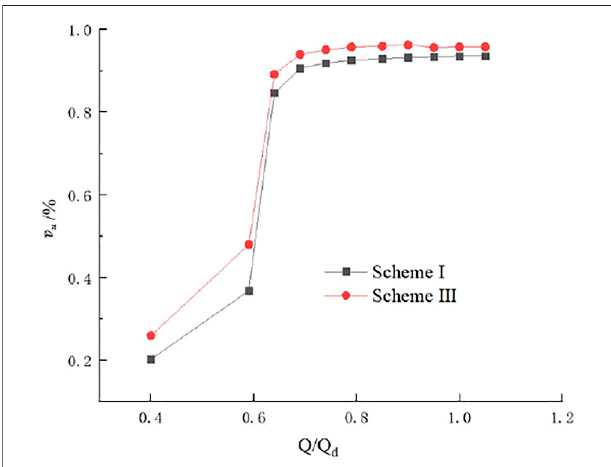
FIGURE 11 | Impeller inlet axial velocity uniformity under all working